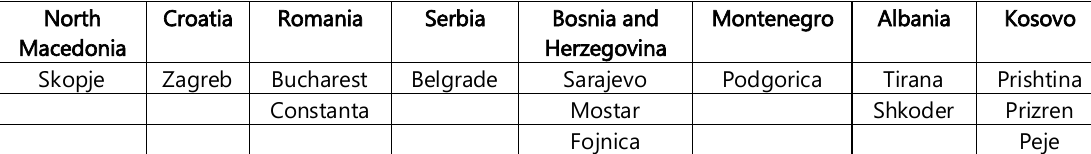
Table 3: Cultural Centres of Yunus Emre Institute in the Balkans (Source: Yunus Emre Enstitüsü 2022)